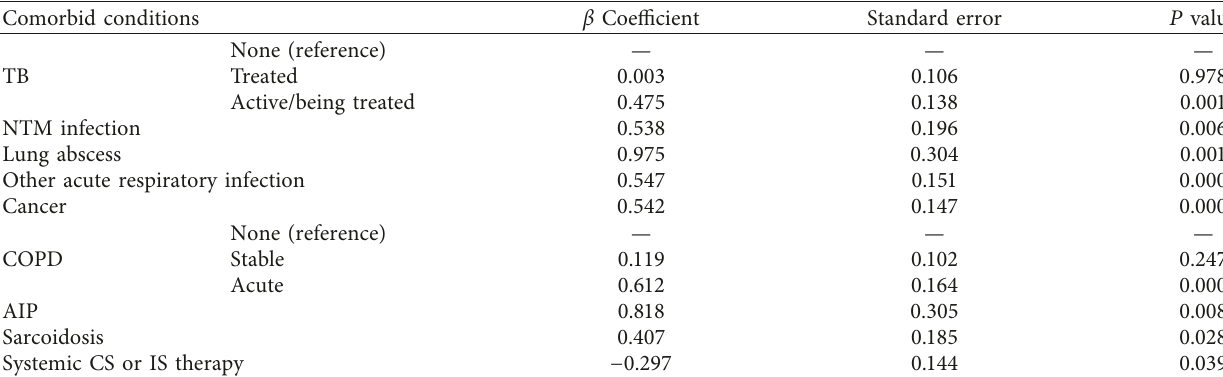
Table 2: Multiple linear regression model for predicting serum IL-1B using age, gender, BMI, smoking status, TB, NTM infection, lung abscess, other acute respiratory infections, cancer, COPD, AIP, sarcoidosis, other interstitial diseases, diabetes mellitus, hypertension, cardiac disease, cerebrovascular disease, systemic CS or IS therapy, and pulmonary surgery history as covariates in all the subjects with chronic pulmonary aspergillosis.